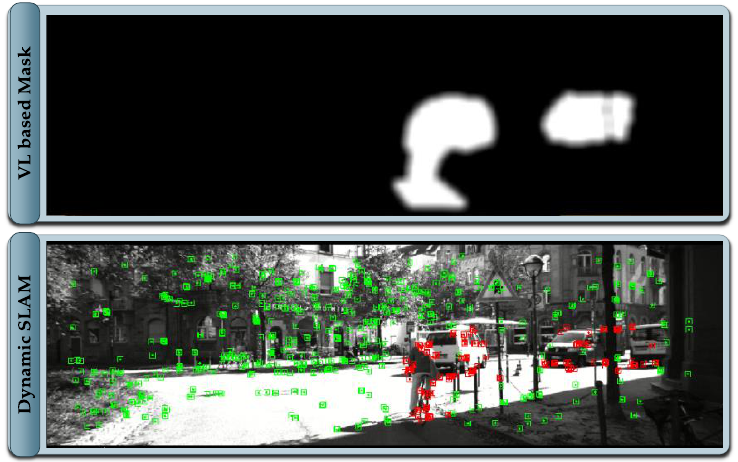
Figure 6. Dynamic SLAM with Visual-LiDAR based dynamic object mask.